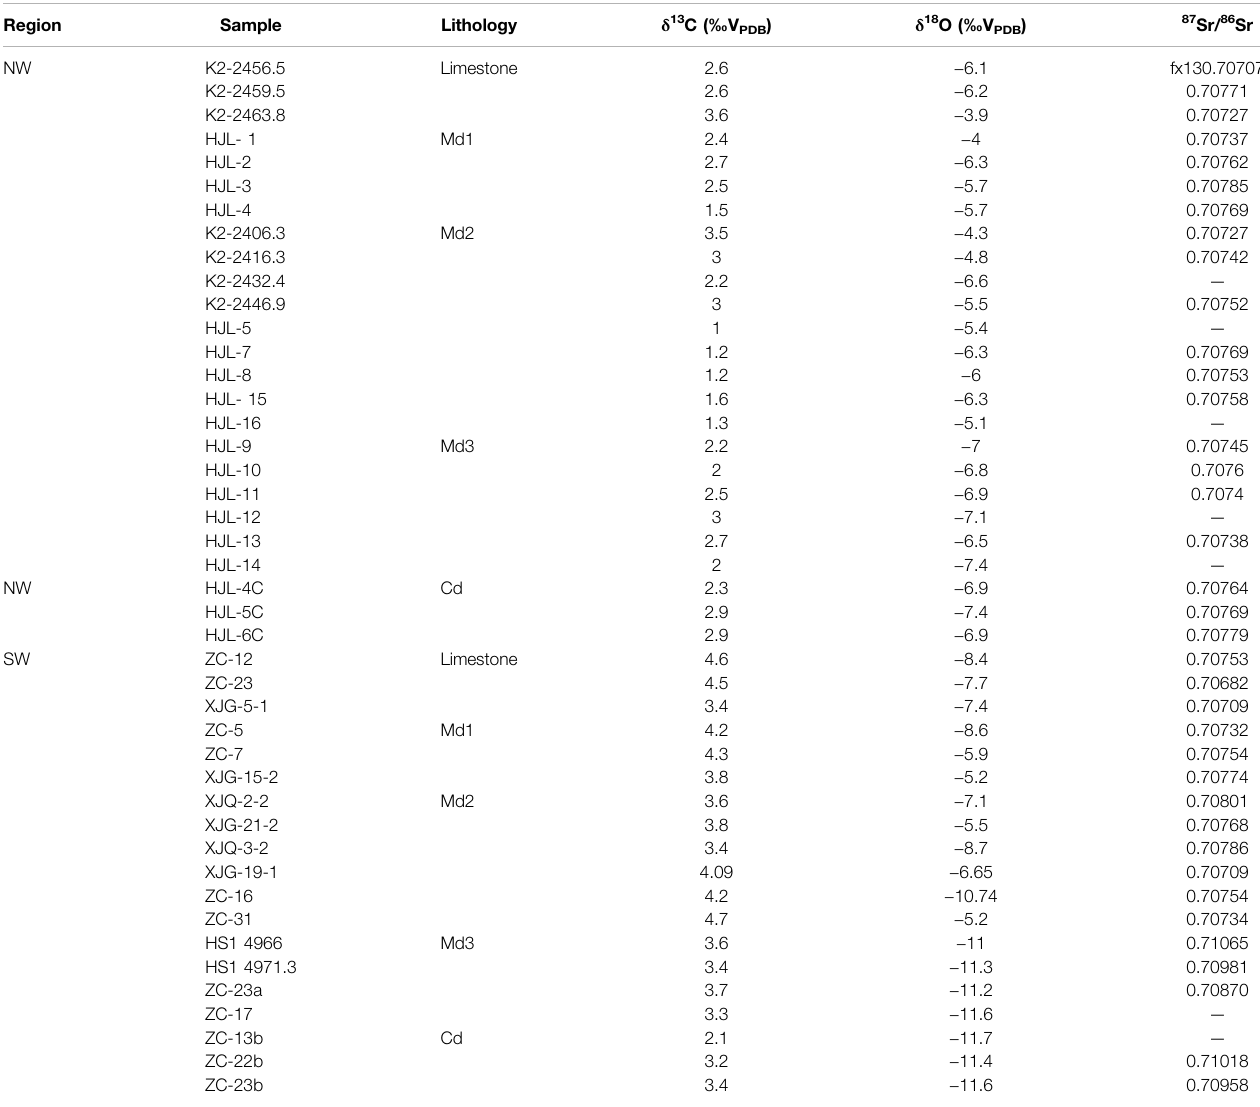
TABLE 1 | Stable isotope data for Middle Permian carbonates of the Western Sichuan Basin. Region